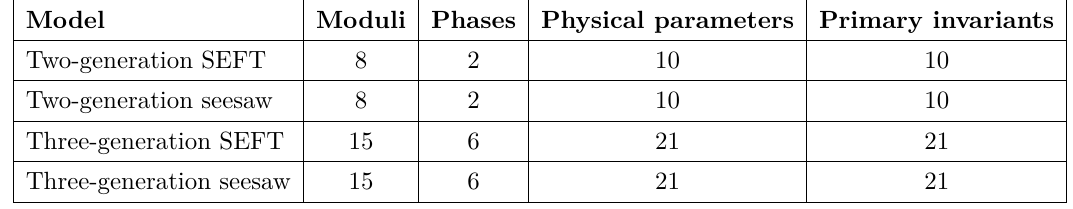
Table 3 . Comparison of the number of independent physical parameters in the theory and the number of primary invariants in the flavor space between the SEFT and the full seesaw model. Note that the moduli denote the parameters in the theory other than phases. It is obvious that the SEFT and the full seesaw model share exactly equal number of independent physical parameters and primary flavor